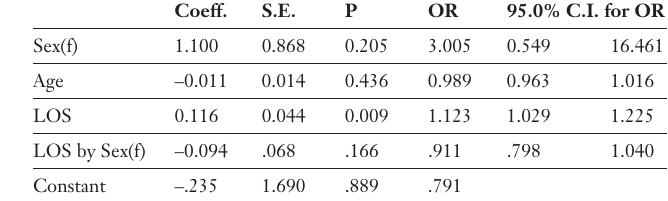
Relationship between nutritional status and LOS, number of drug prescriptions and number of diagnoses (means + standard deviation).